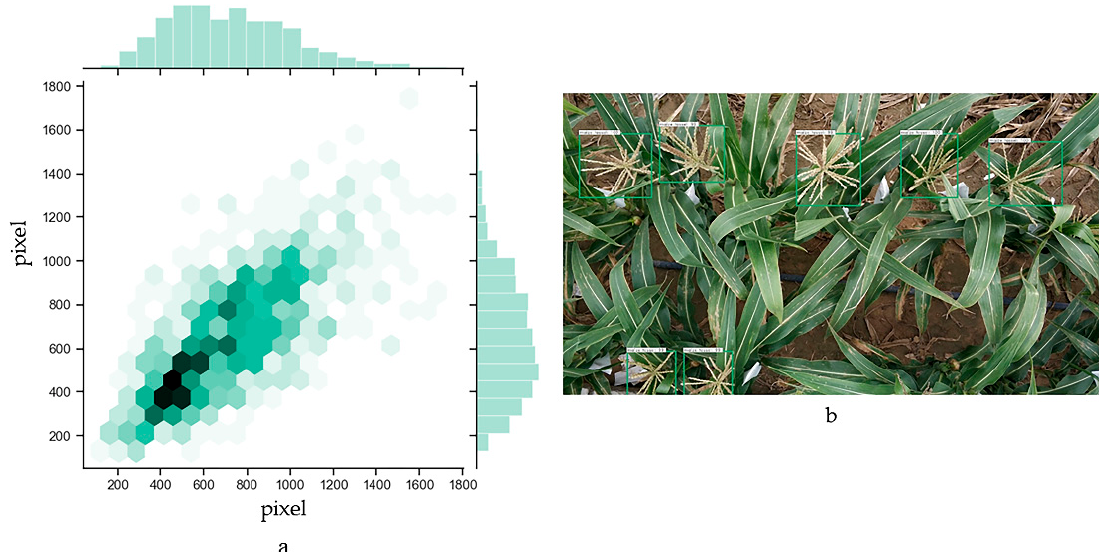
Figure 10. ( a ) The distribution of pixels in the maize tassel images obtained by mobile phone. Images of maize tassel taken 3 m above the ground at the Shangzhuang experimental site. ( b ) The images were detected by the modified anchor size in the Faster R-CNN using ResNet101 as the feature extraction network.